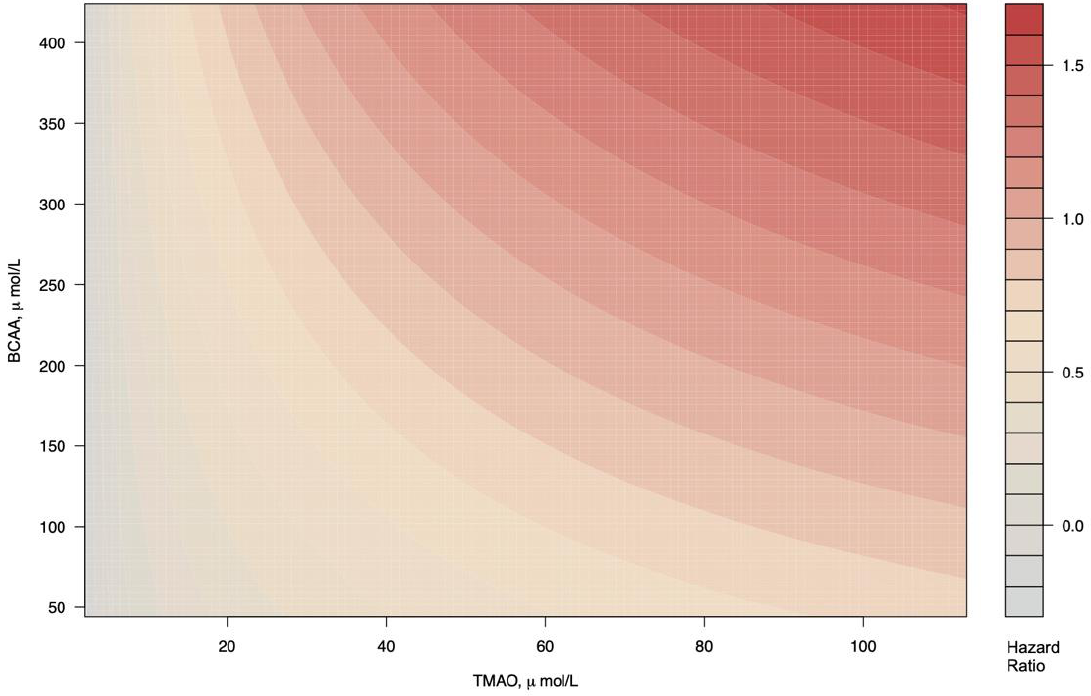
Figure 2. Cardiovascular mortality as a function of TMAO and BCAA in T2D. Subjects with highest concentrations of both BCAA and TMAO present higher risk of cardiovascular mortality.